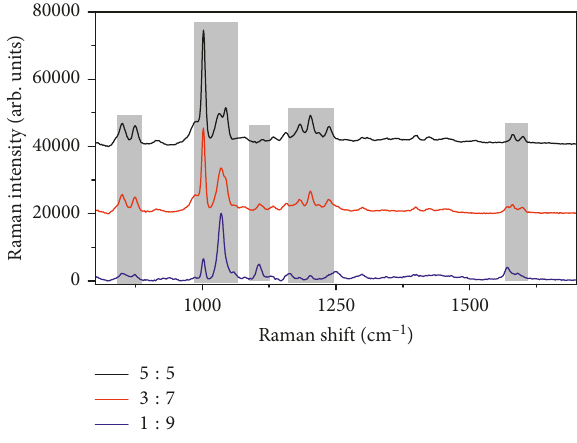
Figure 6: SERS spectra with different mixing